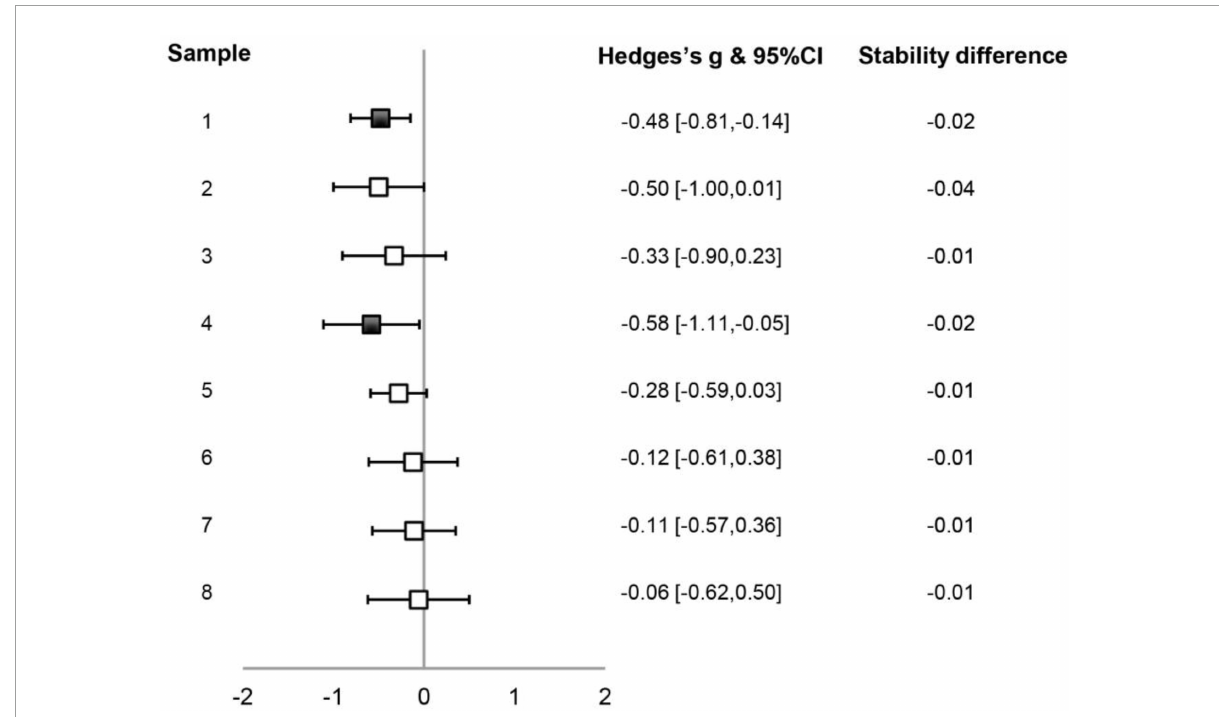
FIGURE2 Illustration of the differences between synchronization stabilities of the auditory tone (AT) and the visual bouncing ball (VB) sequences in the small sample-size data set. For each data sample, Hedges’s g of the stability difference between the two sequence types and the 95% CIs are plotted (filled symbols indicating p < 0.05), with the values listed on the right of the plot. The value of the mean stability difference is also indicated. Other conventions are as in Figure 1 and Table 1